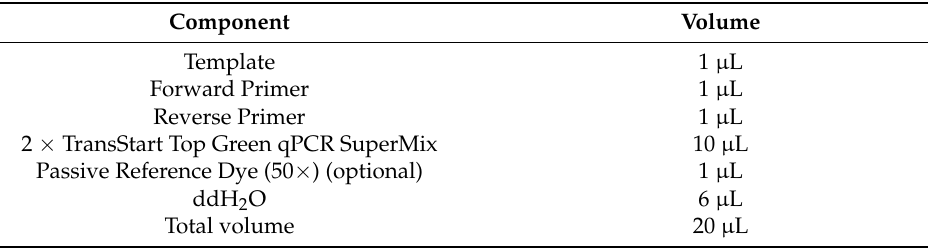
Table 3. Real-time fluorescence quantitative PCR reaction system.